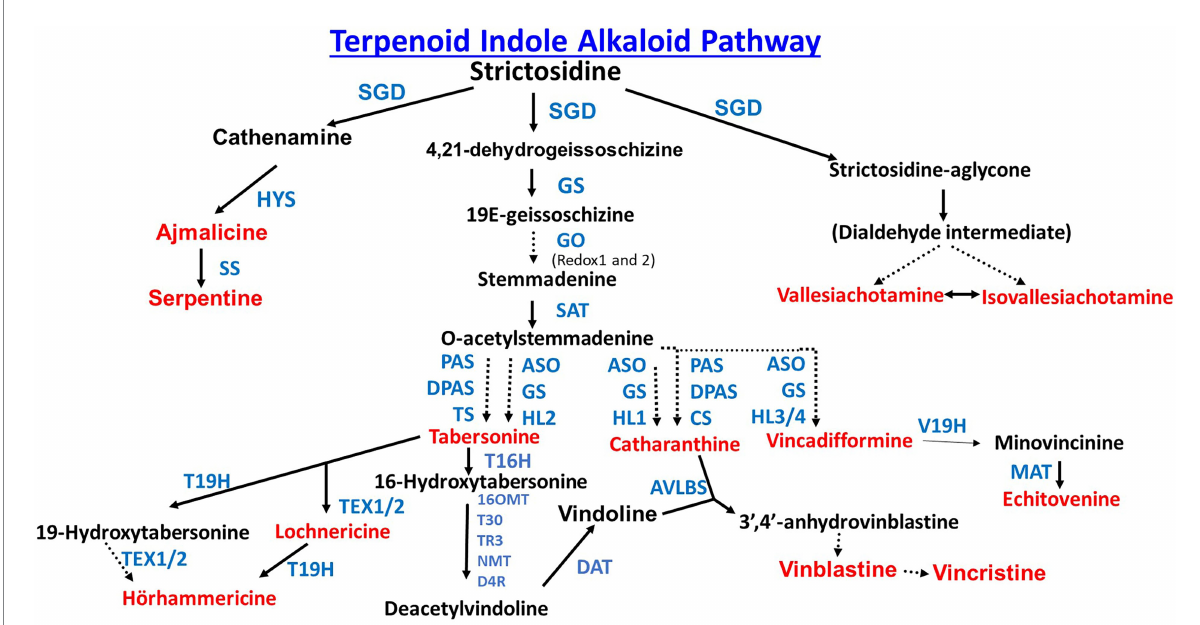
FIGURE 1 Biosynthesis of strictosidine, the common precursor of all terpenoid indole alkaloids. Enzyme abbreviations are as follows: AACT (acetoacetyl-CoA thiolase), AS (anthranilate synthase), CPR (cytochrome P450 reductase), CYP72A1v3 (cytochrome P450 reductase), DXR (1-deoxy-D-xylulose-5- phosphate reductoisomerase), DXS (1-deoxy-d-xylulose-5-phosphate synthase), G10H (geraniol 10-hydroxylase), GES (geraniol synthase), GPPS (geranyl diphosphate synthase), HMGR (hydroxymethyglutaryl-CoA reductase), HMGS (hydroxymethyglutaryl-CoA synthase), IGPS (indole-3- glycerol phosphate synthase), IPI (isopentenyl diphosphate isomerase), MVD (mevalonate 5-diphosphate decarboxylase), MVK (mevalonate kinase), PAT (phosphoribosylanthranilate transferase), PAI (phosphoribosyl anthranilate isomerase), PMK (mevalonate 5-phosphate kinase), SLS (secologanin synthase), STR (strictosidine synthase), TDC (tryptophan decarboxylase), and TS (tryptophan